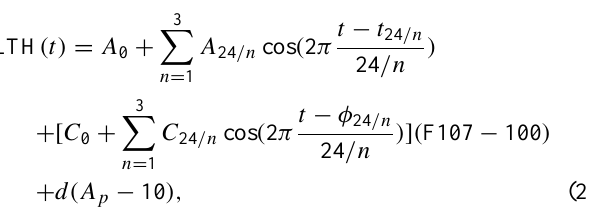
Figure 10. Mass plot of the differences d h (open circles) between the calculated LTH at certain Ap and at Ap=10 for various seasons and all local times (1-24 LT) as a function of magnetic activity. The solid line is the results of a linear regression.